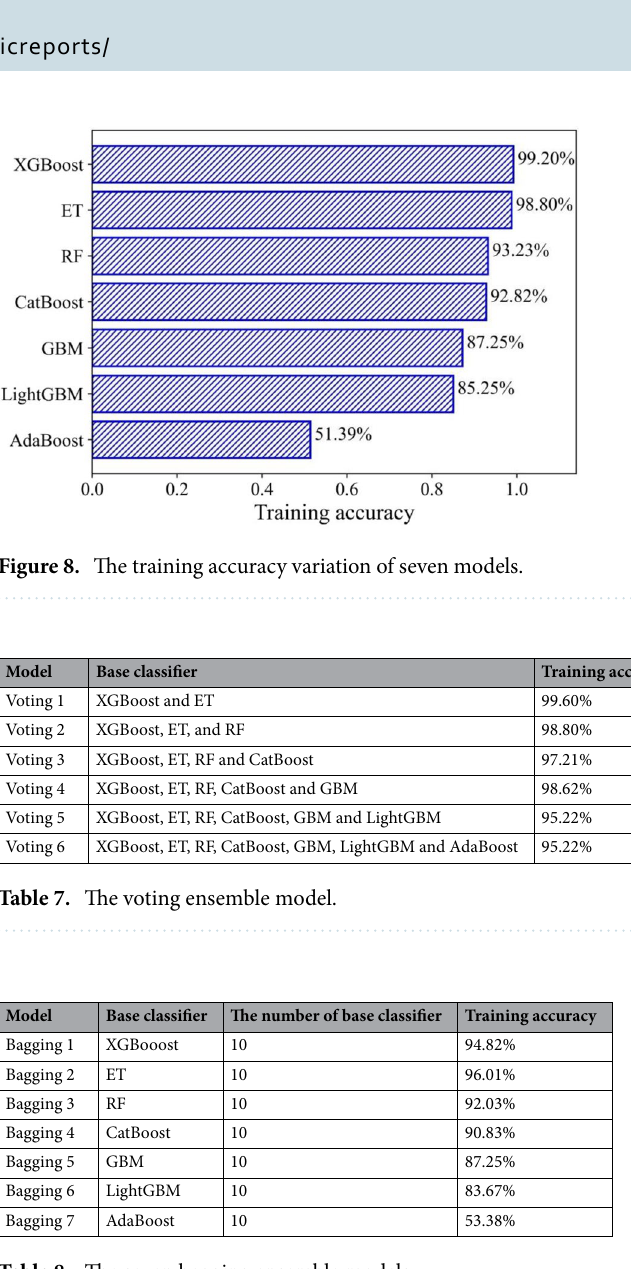
Table 8. The seven bagging ensemble models.